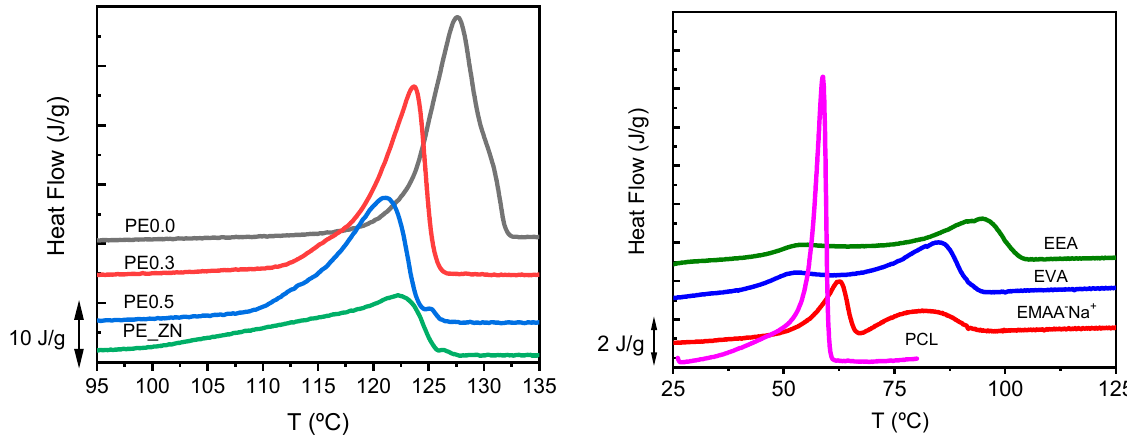
Figure 2. DSC traces of the single crystals of the polyethylenes ( left ) and matrices ( right ) at a heating rate of 10 °C·min − 1 .